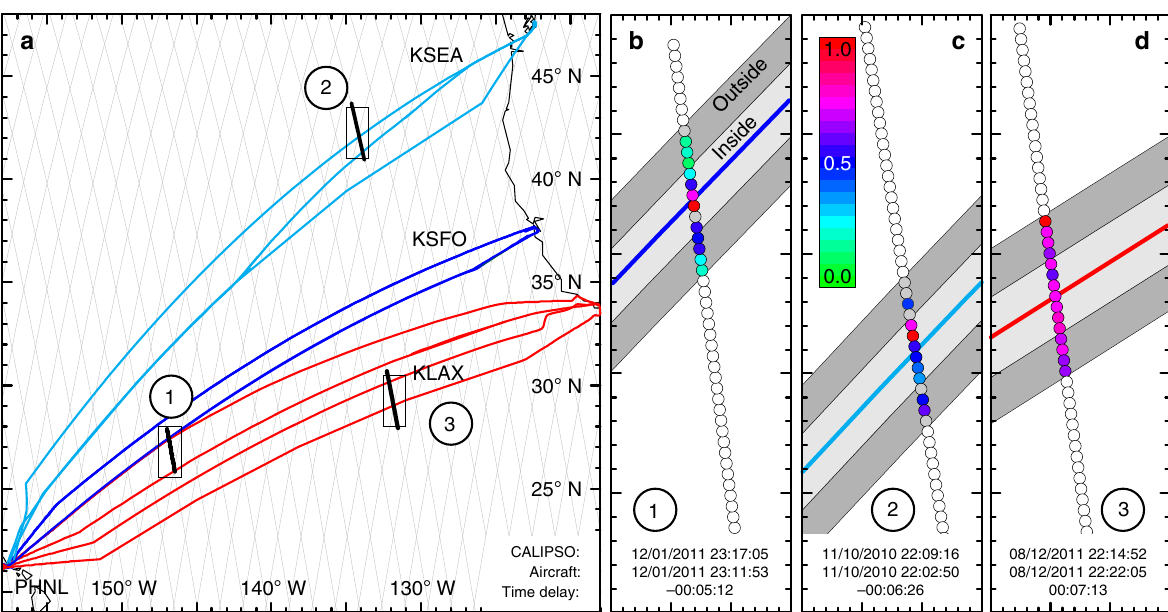
Figure 1 | Overview of the analysis approach. ( a ) Typical aircraft flight tracks (coloured lines) and CALIPSO satellite trajectories (grey lines for 16-day cycle, black lines for example cases). ( b – d ) Close-up of three example overpasses indicated in a with values of normalized cirrus optical thickness (coloured dots) and illustration of the inner and outer track (light and dark grey shading, respectively). White and grey dots in b – d refer to data that have not been considered in the analysis and do not fulfil the quality assurance criteria, respectively. Times of CALIPSO and aircraft overpasses are given at the bottom of b – d . Negative and positive time delay values indicate that the aircraft arrived at the scene before and after, respectively, the satellite